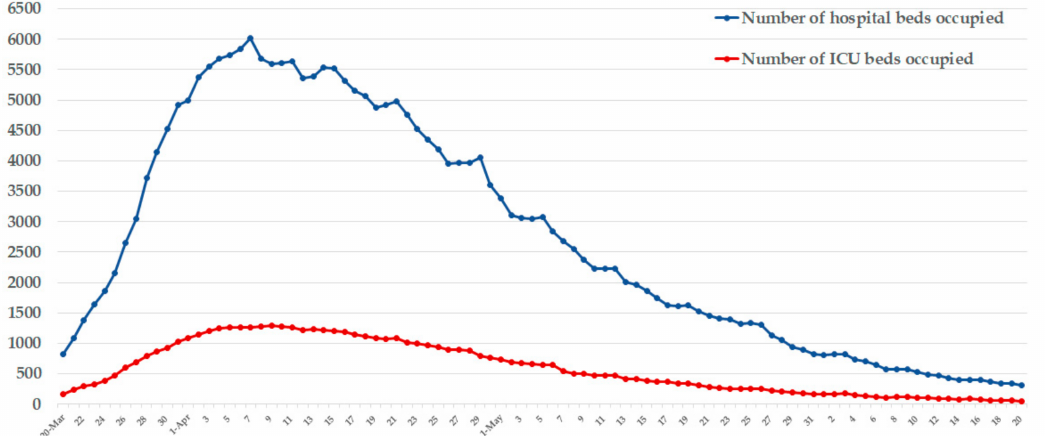
Figure 4. Number of hospital and ICU beds occupied of COVID-19 in